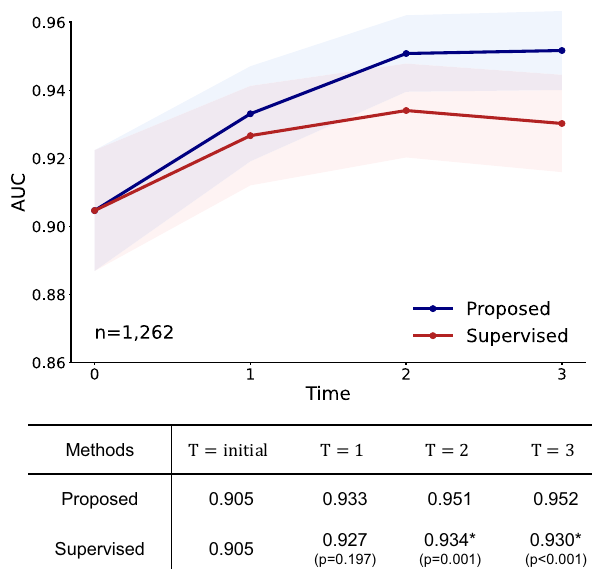
Fig. 8 Tuberculosis diagnosis results for validation in a cohort of bacteriological laboratory-con fi rmed tuberculosis cases. In a cohort from another corelab consisting of 727 normal cases and 535 con fi rmed tuberculosis cases, the model obtained with the DISTL framework offered performances superior to those of the fully supervised model trained with the same amount of labeled data. Data are presented with calculated area under the receiver operating characteristics curves (AUCs) in the study population (center lines)±95% con fi dence intervals (CIs) calculated with the DeLong's method (shaded areas). The AUCs of the proposed method and the supervised learning method were compared at each time point T with the DeLong test to evaluate statistical signi fi cance, except for the T = initial where the two methods start from the same baseline. * denotes statistically signi fi cant ( p <0.050) superiority of the proposed framework. All statistical tests were